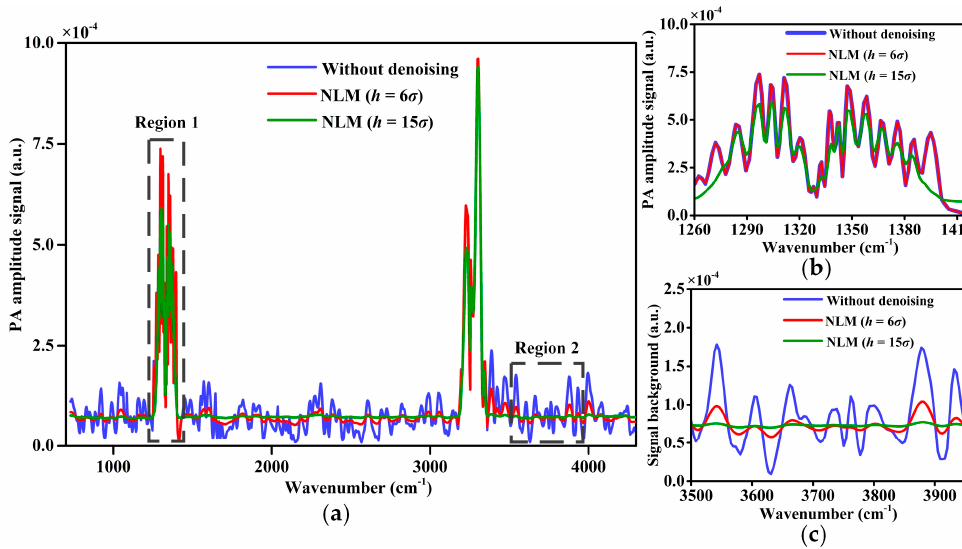
Figure 3. Comparison of 100 ppm C 2 H 2 PA signal denoising results based on basic NLM using different smoothing parameters: ( a ) denoised spectra using NLM with h = 6 σ and h = 15 σ ; ( b ) enlargement of region 1: comparison of absorption peaks; ( c ) enlargement of region 2: comparison of background noise.